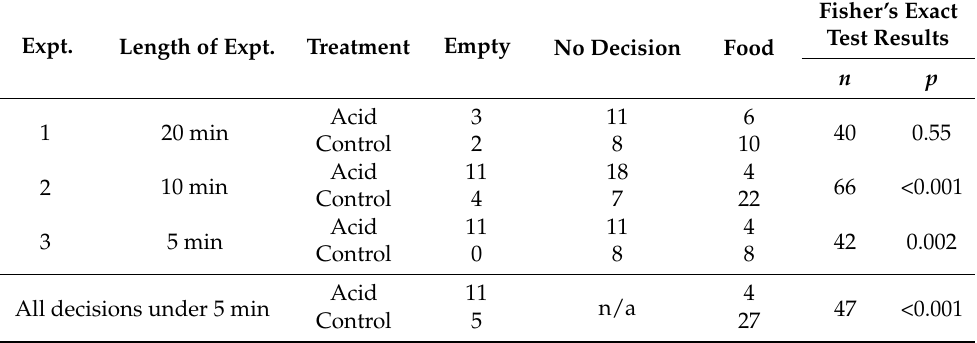
Table A1. Snail decisions for each of the three experiments as well as Fisher’s Exact Test results for each of the statistical comparisons between control and acidified conditions. The bottom rows show the combined dataset that included all snails that made decisions in less than 5 min across all